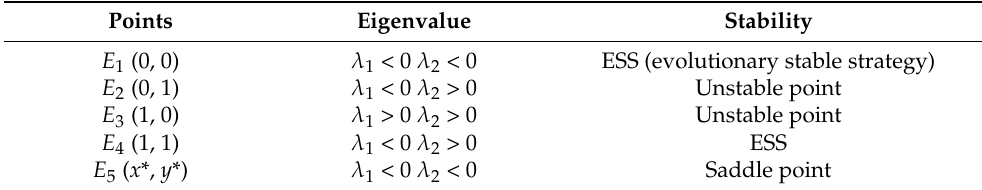
Table 6. The asymptotic stability condition.